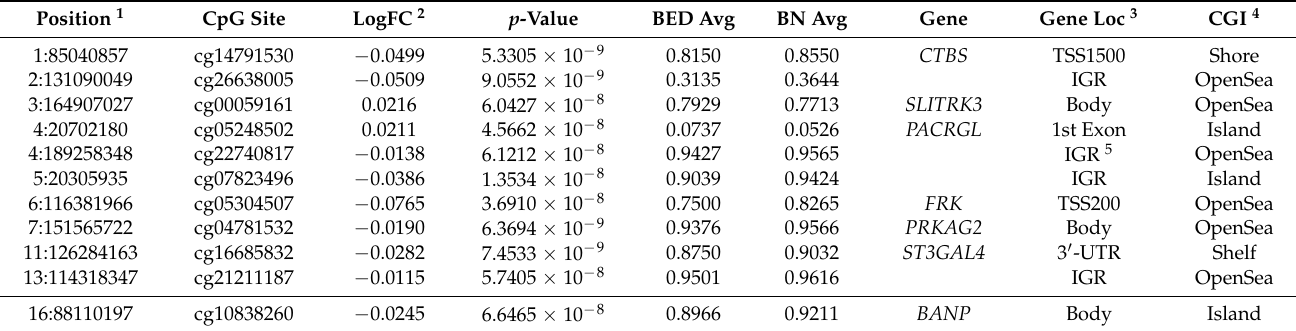
Table 2. Differentially methylated sites in bulimia nervosa and binge-eating